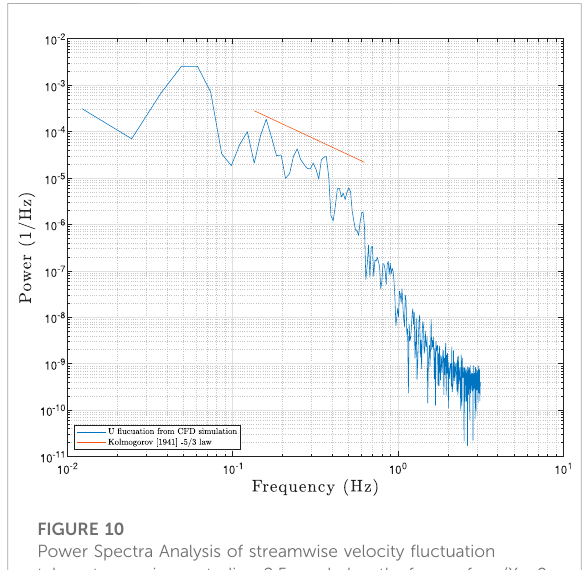
FIGURE 10 Power Spectra Analysis of streamwise velocity fl